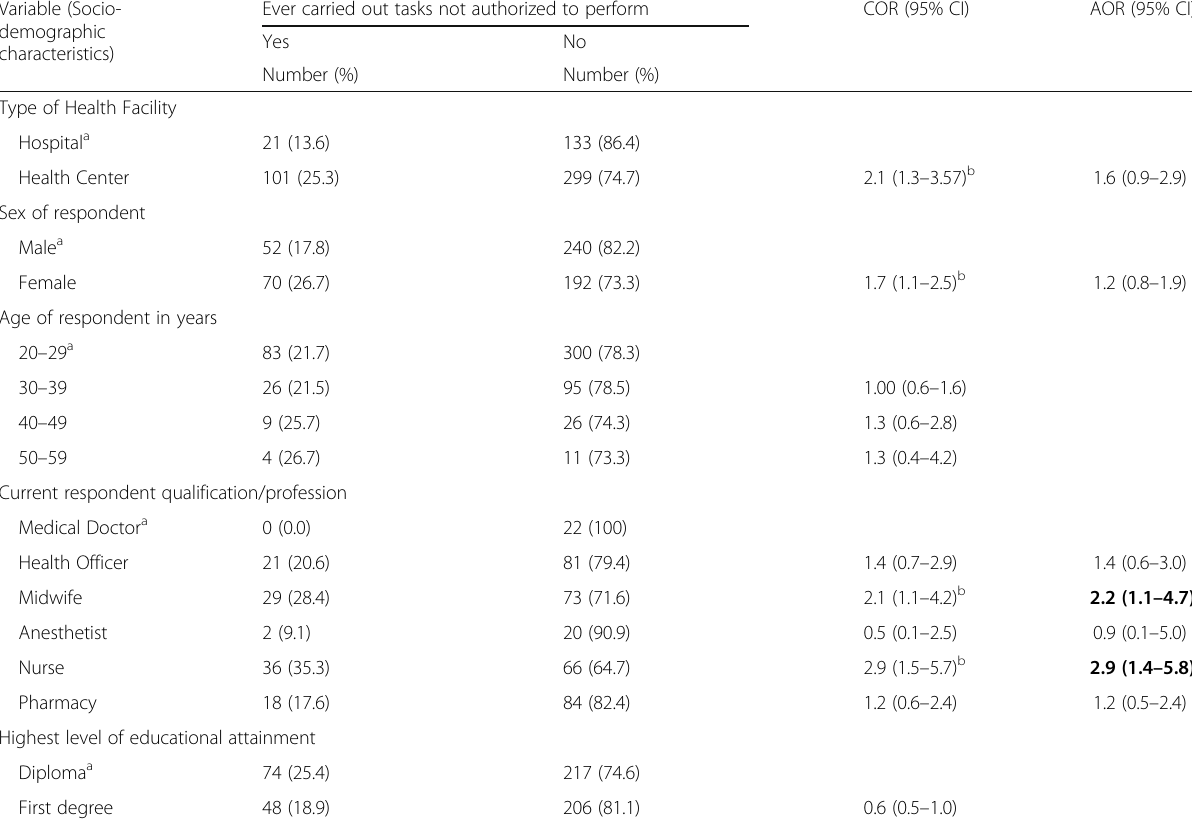
Table 4 Factoring affecting scope breach, exploring health workforce regulation practices and gaps, Ethiopia, 2015 Variable (Socio- demographic